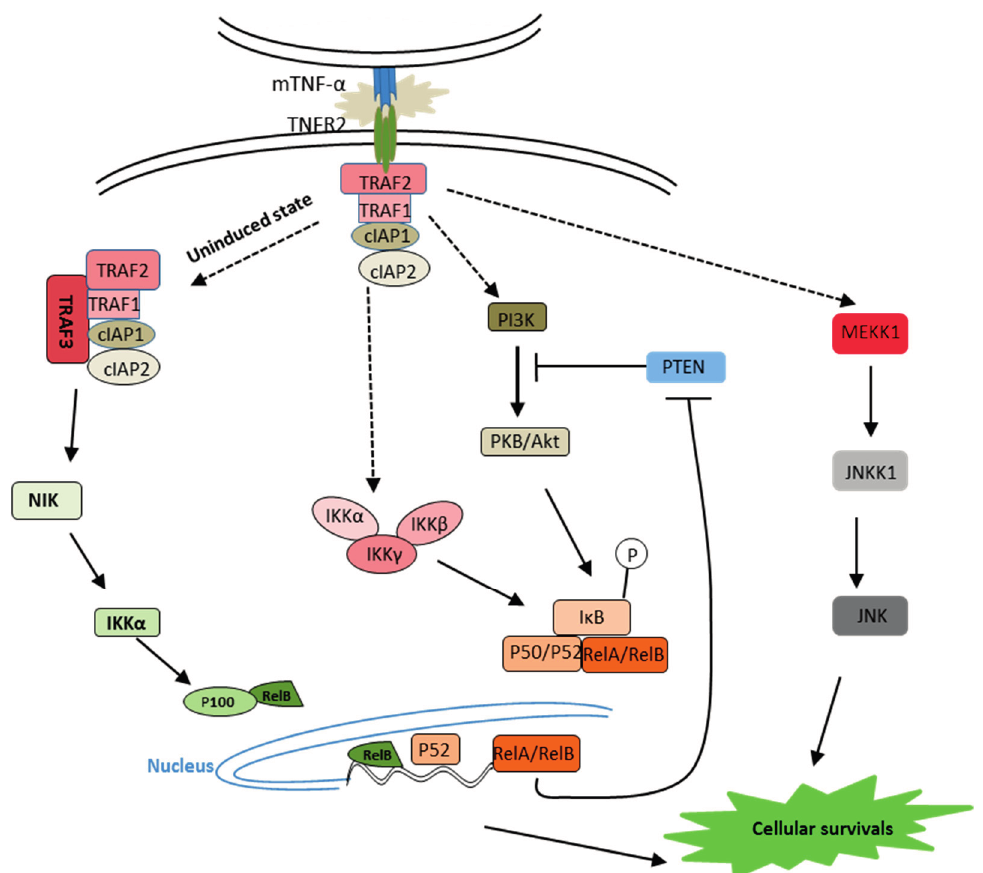
Figure 2. Multiple forms of TNFR2 signaling activation are mediated through intracellular protein complex assembly. The transmembrane trimeric TNF- α engagement of TNFR2 leads to cellular survival via the distinct complex signaling pathways. PKB/Akt signaling is described in